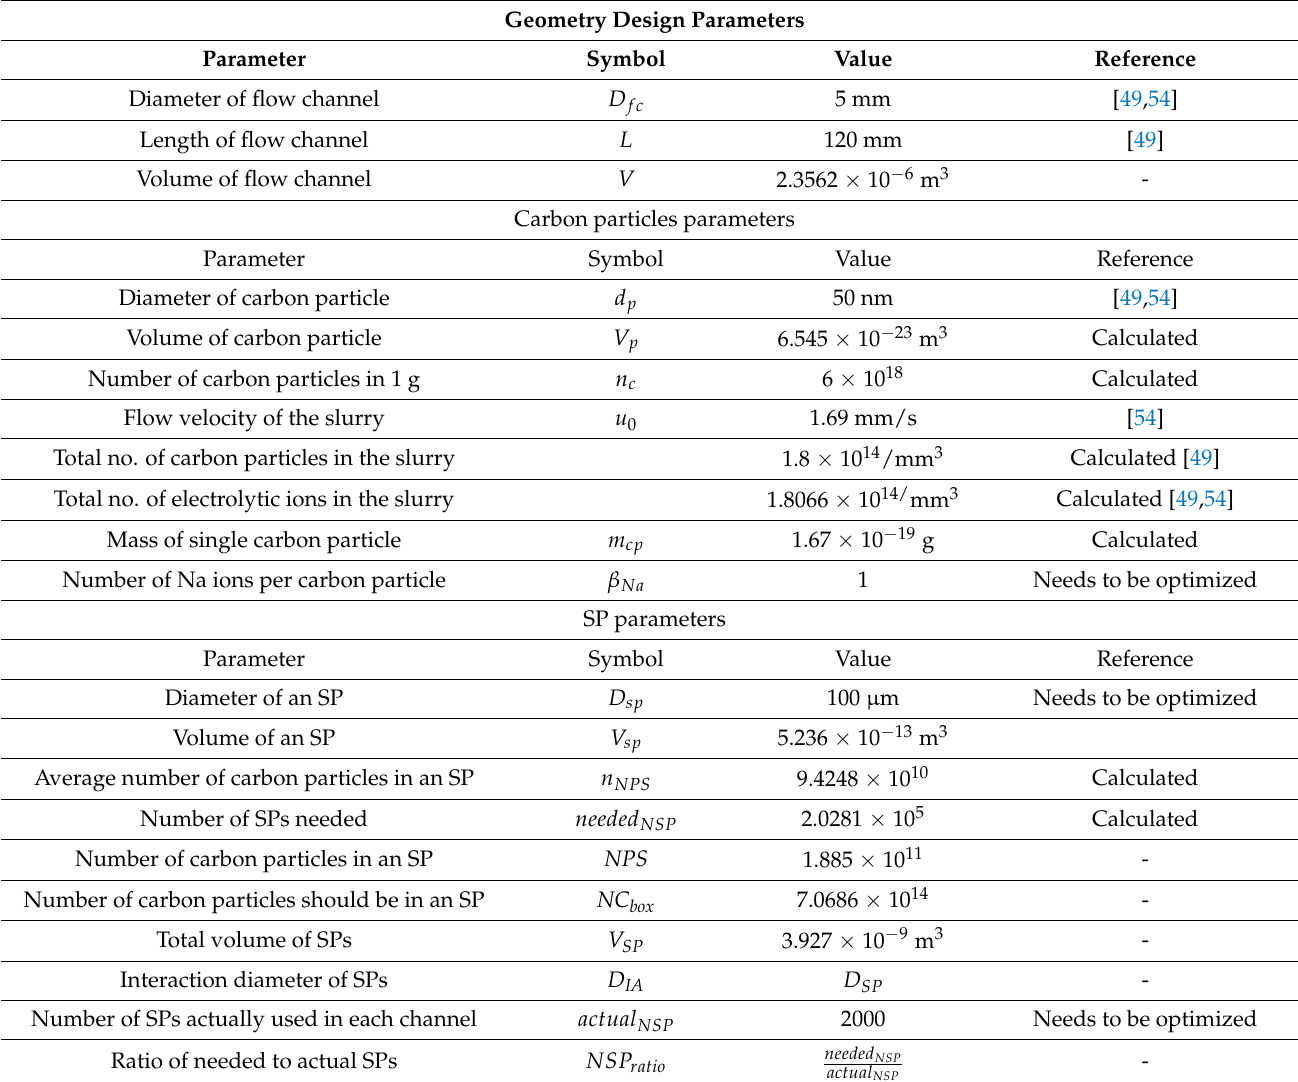
Table 1. Parameters for the particle-based stochastic